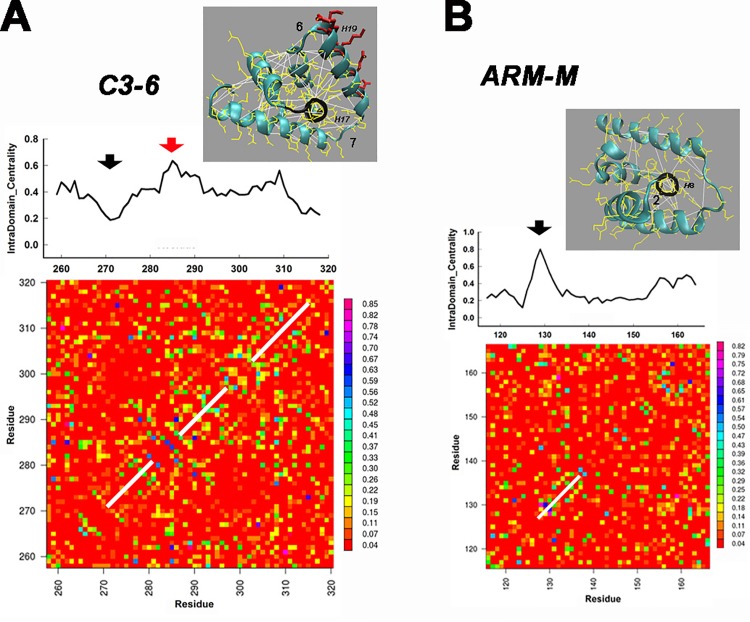
The contact networks of the ARM-M and C3-6 domains.Contact (< 12 angstrom) centrality profiles are positioned on top of their respective coevolution matrices. Matrix segments with white lines along the positive diagonal show the α-helical repeat correlations that generate positive correlations spaced four residues apart, parallel to the white lines. Vertical bars show the colour-coded scale for correlation values as in Fig 3. Numbers in images indicate primary network nodes in the FliG centrality profile (Fig 6A). (A) The C3-6 coevolution matrix. The torque helix H19 is the primary node (red arrow) in the centrality profile. The short, hub helix (H17 –black arrow) is adjacent to the linker between the torque-helix and the terminal helix (H20) Image: The high-scoring correlations (white lines) mapped onto the 3HJL.pdb C3-6 (cyan backbone, yellow side-chains). H19 (conserved charged residues = red side-chains) and H17 (black backbone) are marked. (B) The ARM-M coevolution matrix. Correlations between a short helix (H8 -black) and surrounding helices form a pin-wheel pattern. The H8 helix adjacent to the EHPQ motif forms the primary node (black arrow) in the ARM-M contact centrality. Image: The high-scoring correlations mapped onto 3HJL.pdb ARM-M. The correlations and backbones are coloured as in A.